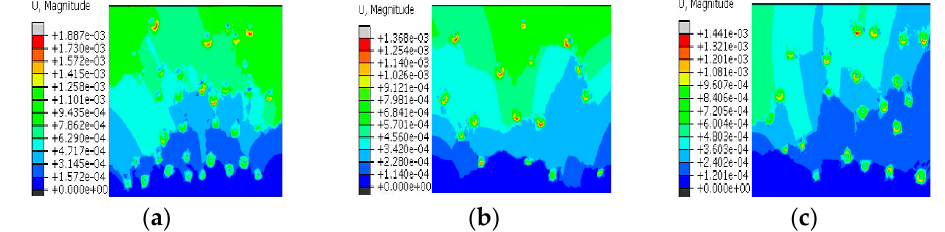
Figure 12. Model 1–3 axial displacement nephogram. ( a ) Model 1; ( b ) Model 2; ( c ) Model 3.